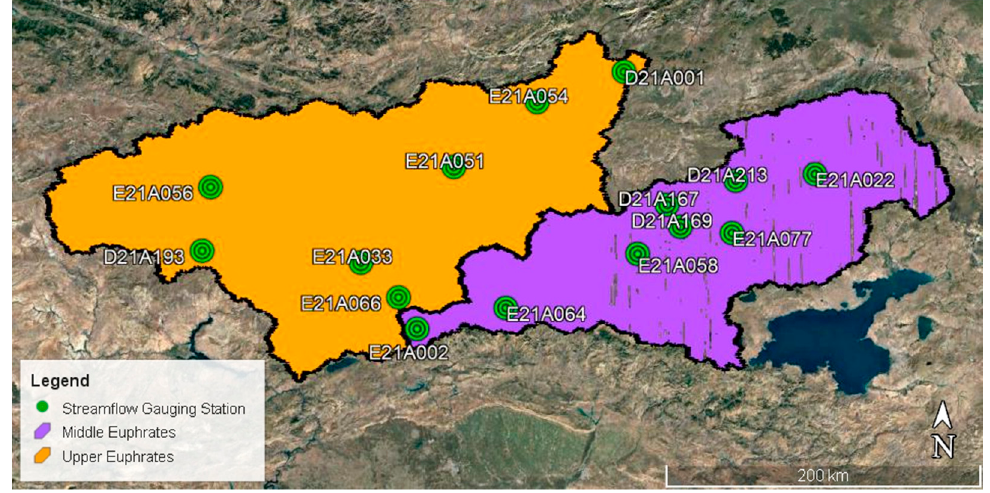
Figure 2. Location of the two selected basins with streamflow gauging stations.